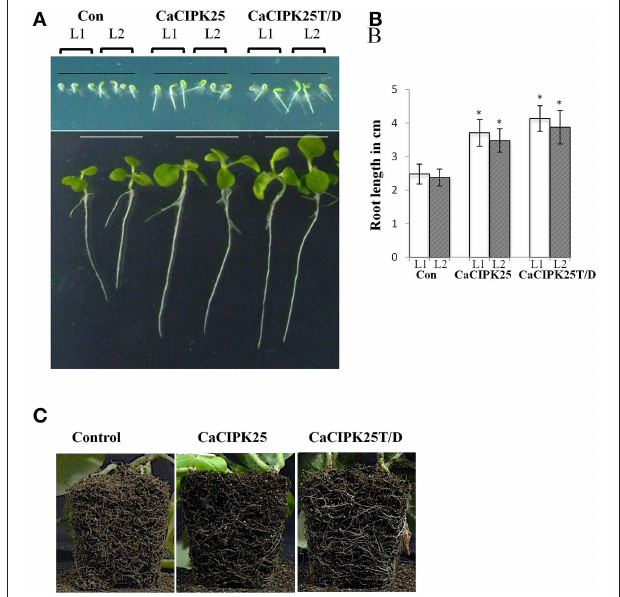
FIGURE 6 | Morphology of CaCIPK25 overexpressing transgenic tobacco lines. (A) Morphological comparison of vertically grown tobacco seedlings transformed with empty vector (Con), CaCIPK25 and CaCIPK25T 171 D genes. Transgenic seeds from two lines (L1 and L2) are represented for all the constructs, upper and lower panels are showing 2 − and 15 − days old seedlings after germination, respectively. (B) Comparison of root lengths of 15-days old seedlings. Averages of three measurements of 15 seedlings each are shown. * indicates statistically significant difference ( p < 0 . 05 ) from the control sample. (C) Root system of soil-grown 50 days-old transgenic tobacco plants. Roots exposed to the soil surface are